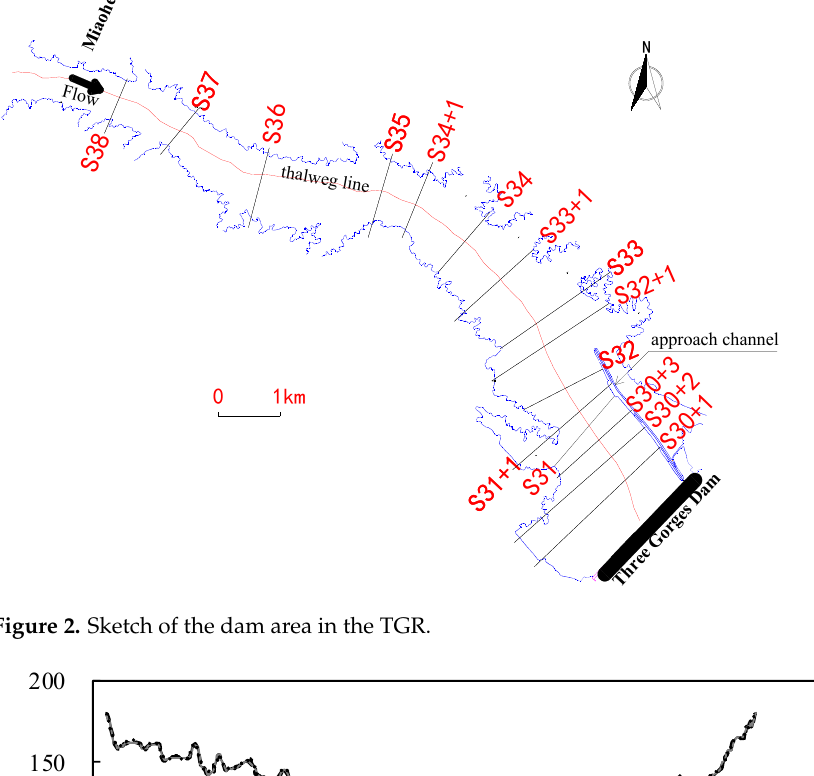
Figure 2 . Sketch of the dam area in the TGR.